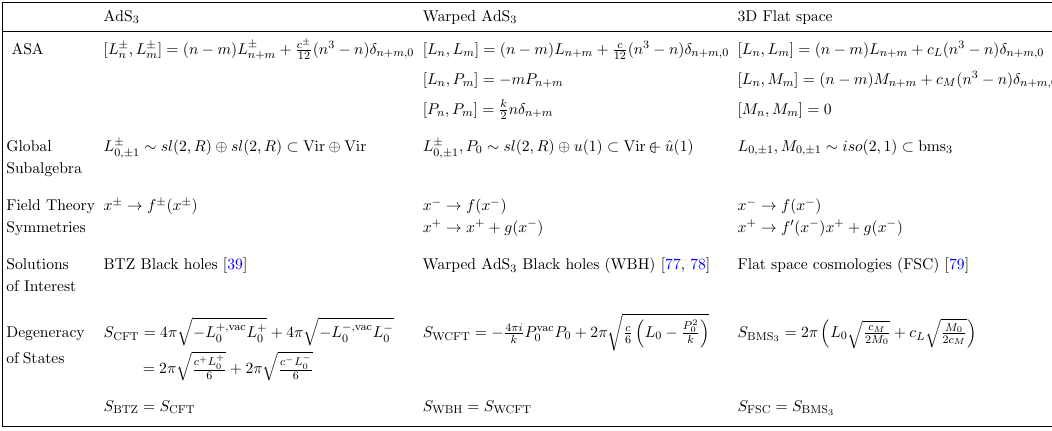
Table 1 . Three scenarios in 3d